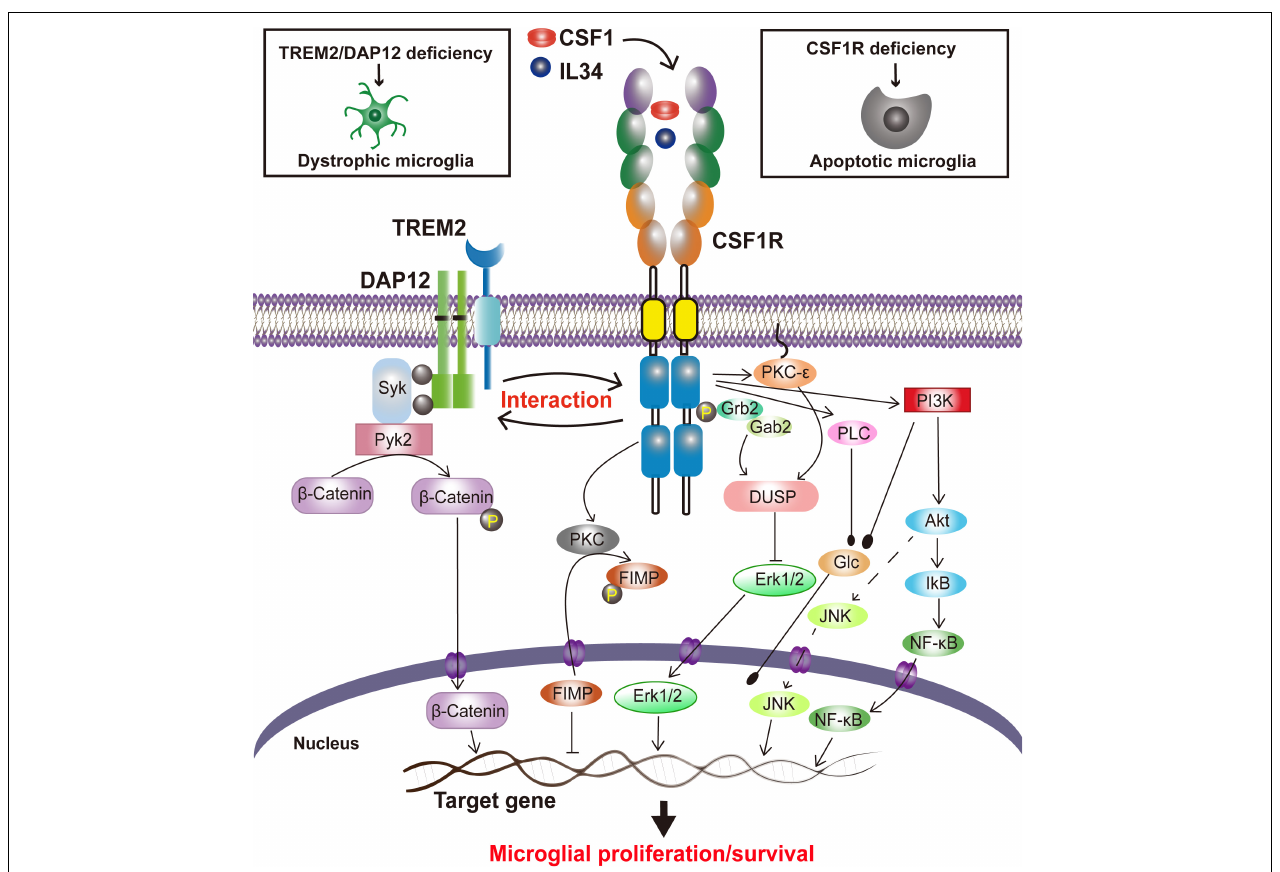
FIGURE 1 | Proposed CSF1R-mediated signaling in microglial survival and proliferation. Stimulated by the ligands, CSF1 or IL34, CSF1Rs are undergoing a rapid dimerization, a self-tyrosine phosphorylation, and activation of PI3K/Akt, JNK, and ERK1/2 pathways, regulating microglia proliferation and survival. CSF1R also interacts with TREM2/DAP12, mediating microglial